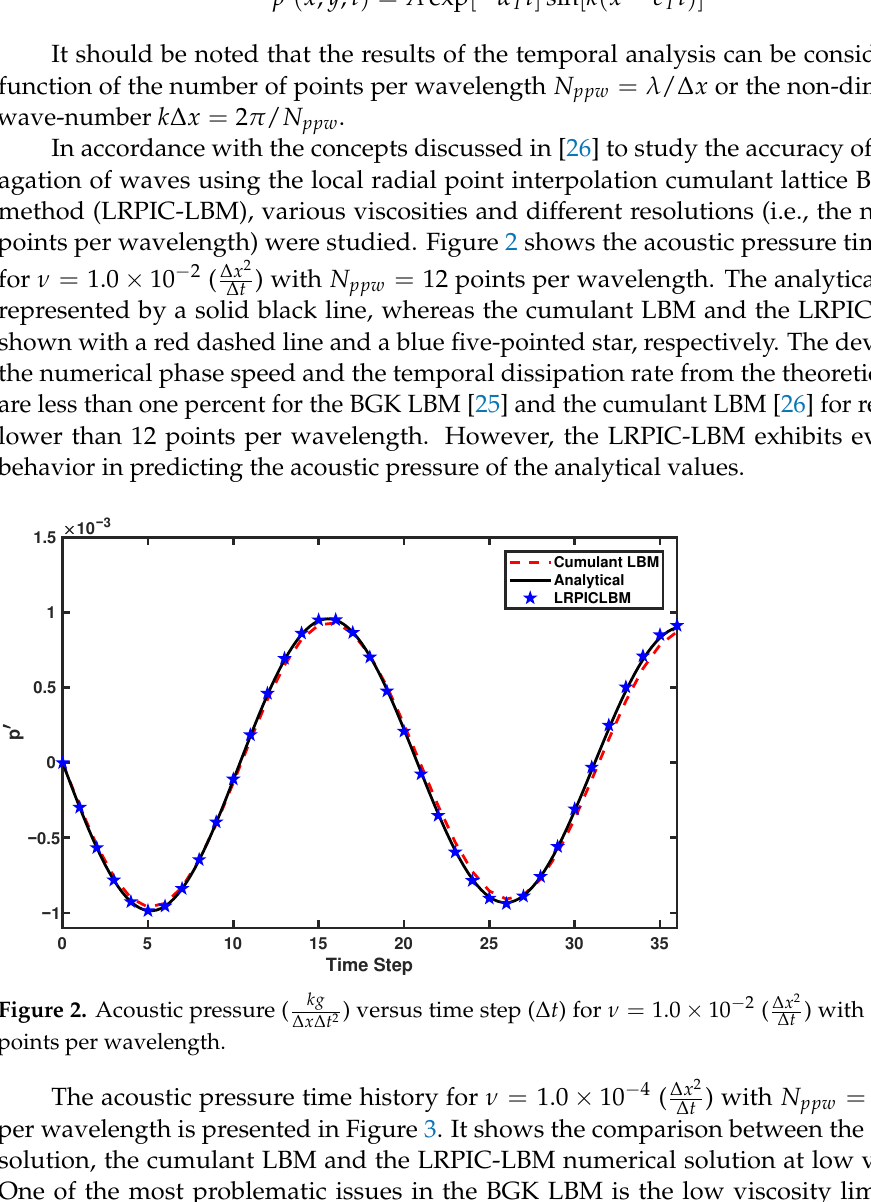
) versus time step ( ∆ t ) for ν = 1.0 × 10 − 2 ( x ∆ t 2